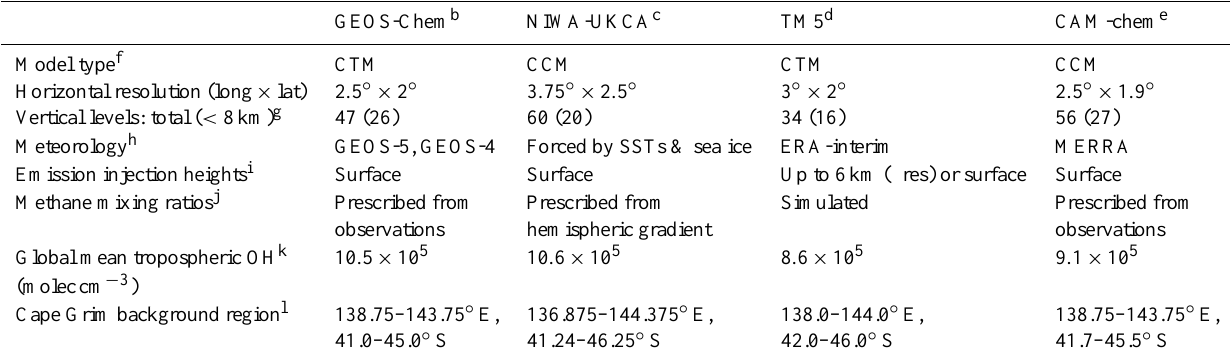
Table 1. Details of model simulations used in SHMIP a